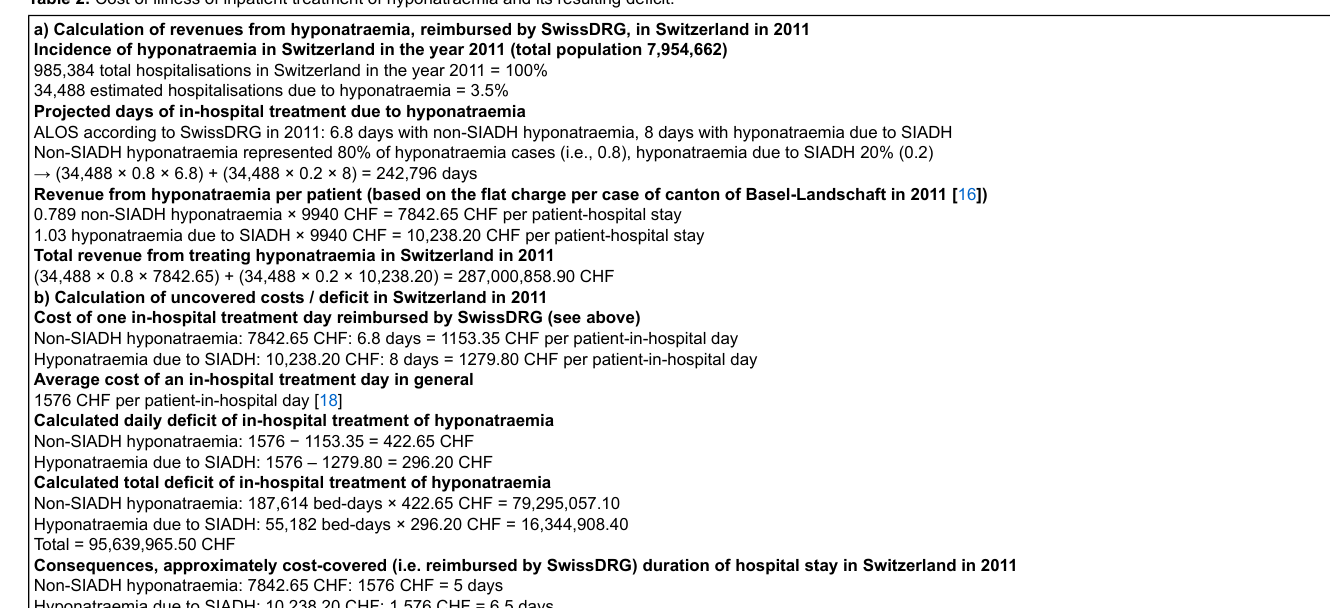
Table 2: Cost of illness of inpatient treatment of hyponatraemia and its resulting